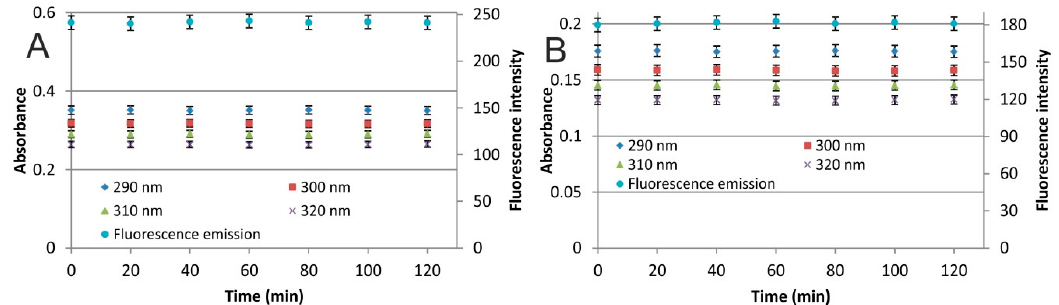
Figure 5. Absorbance (at 290, 300, 310, and 320 nm) and fluorescence values of ( A ) CNDs-DS and ( B ) CNDs-CA solutions, irradiated with a 150W Xenon lamp; data are presented as means ± standard deviation; n = 3.